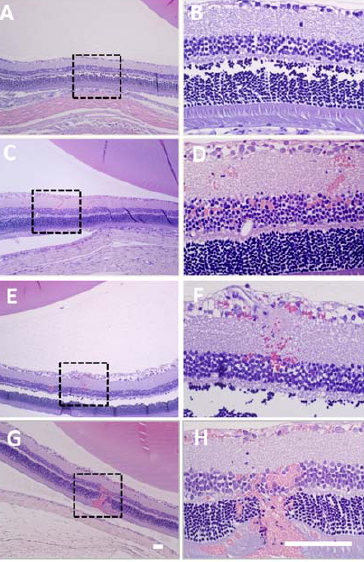
Figure 5. Microphotographs of H&E-stained sections from representative examples from each experimental group (Table 1). Images on the right are high-magnification views of the boxed regions shown on the left. ( A–B ) Non-sonicated (control) eye. ( C–H ) The largest effects found on histological examination in each BRB disrupted eye at increasing acoustical pressure amplitudes: ( C–D ) 0.81 MPa; ( E–F ) 0.88 MPa; ( G–H ) 1.1 MPa. At 0.81–0.88 MPa, the retina and other ocular structures appeared mostly normal except for tiny petechaie found in the nuclear layers of the retina. At 1.1 MPa, more extensive petechaie were found. The animals were sacrificed 24 h after Scale bars: 100 m m.